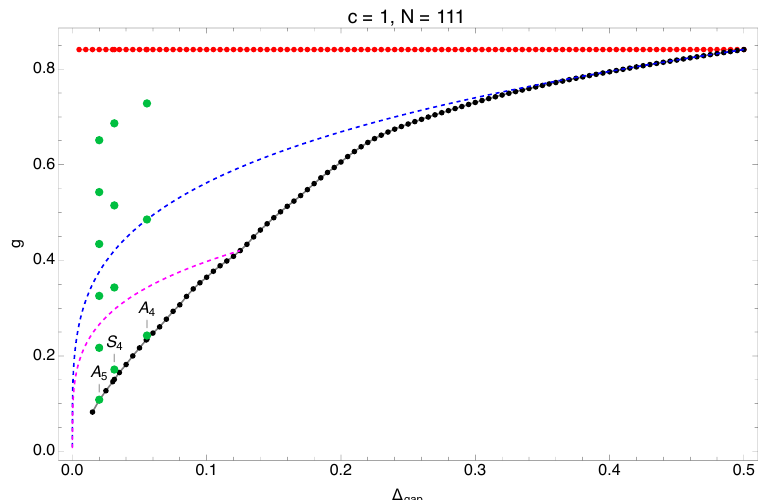
Figure 4. Upper (red) and lower (black) bounds on the g -function for stable boundary conditions in c = 1 CFTs as a function of the gap in the bulk scalar sector. The dashed blue and magenta lines denote the curves ∆ 1 / 4 gap and 2 − 1 / 2 ∆ 1 / 4 gap , corresponding to the g -functions of the Dirichlet boundary conditions on the circle and orbifold branches, respectively. The latter truncates at ∆ gap = 1 to the moduli-independent gap in the twisted sector. The green points denote the g -function of the stable rational branes in the exceptional orbifold